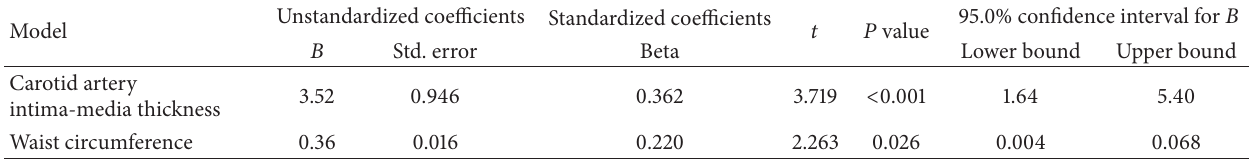
Table 3: Independent predictors for epicardial fat thickness by multivariate stepwise linear regression analysis.